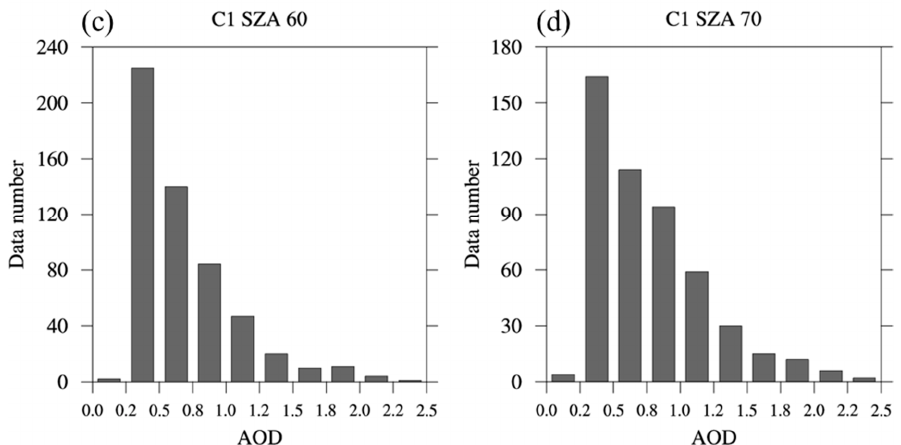
Figure 1. Histogram of observation data number with respect to AOD for solar zenith angle (SZA) of: ( a ) 40°; ( b ) 50°; ( c ) 60°; and ( d ) and 70°, in C1 cases.